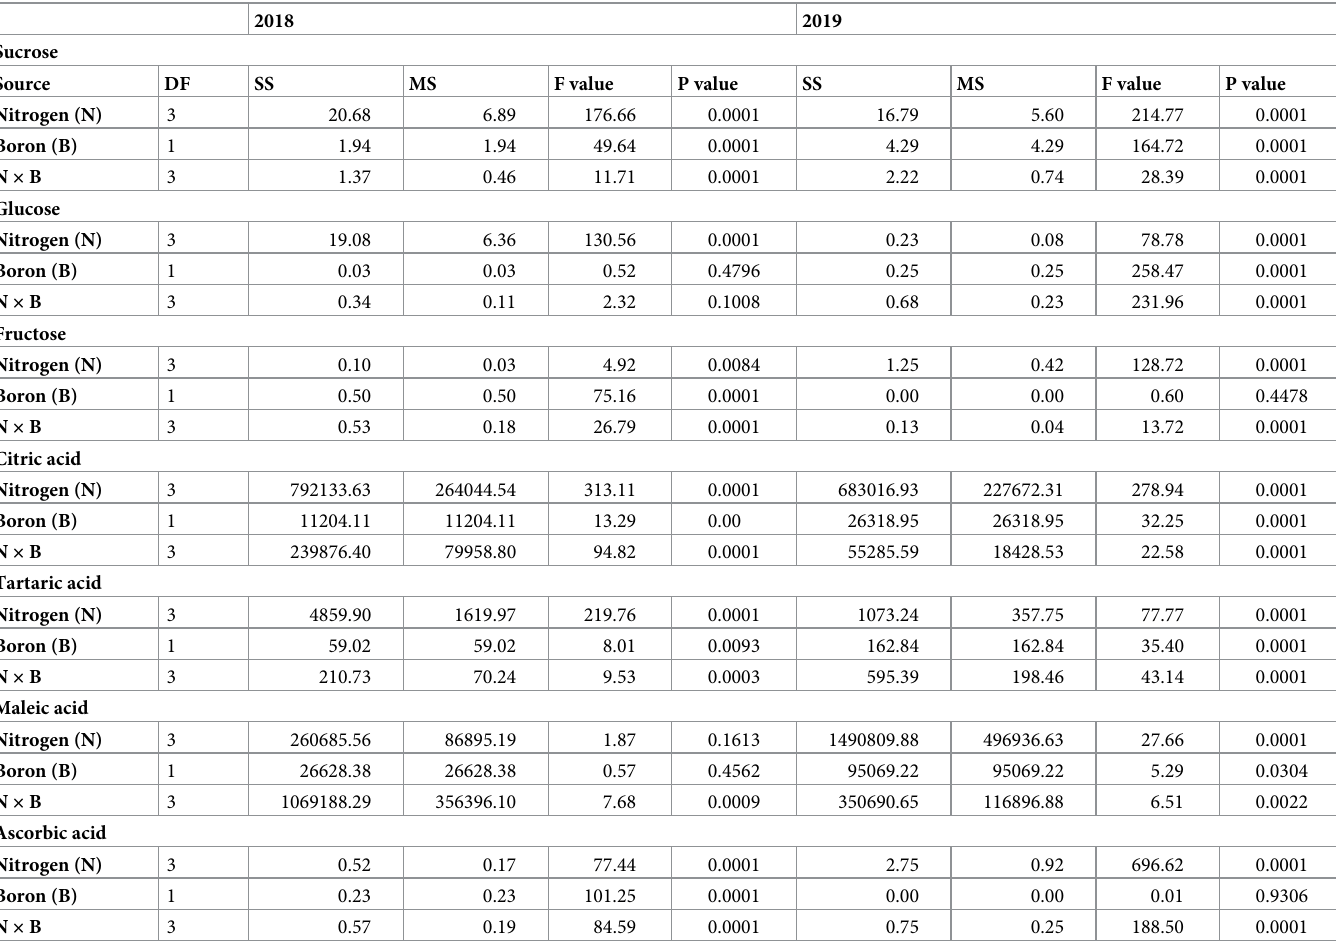
Table 4. Analysis of variance for different quality traits of grafted watermelon grown under varying nitrogen and boron levels. 2018